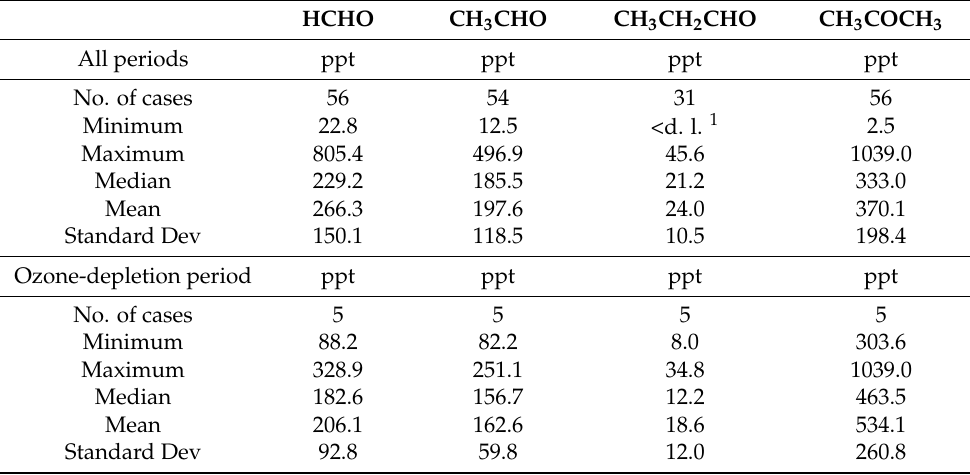
Table 3. Statistics for carbonyl compound concentrations during the Arctic campaign of